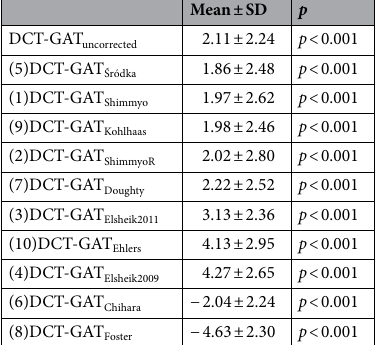
Table 2. DCT and GAT (corrected with different formulas) difference in mmHg. DCT Dynamic contour tonometry, GAT Goldmann applanation tonometry, SD Standard deviation, p Level of significance according to paired T-test.